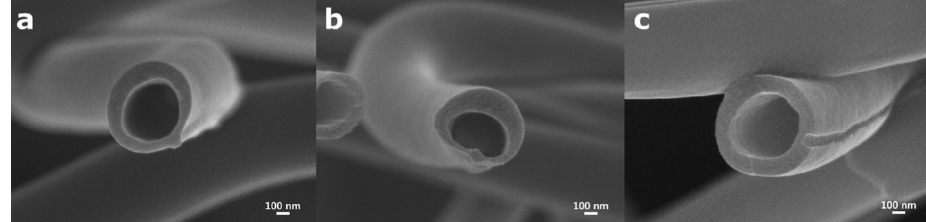
Figure 11. Different morphologies of hollow carbon nanofibers fabricated via different nozzle setups, ( a ) normal nozzle (the core and shell nozzle outlets meet at the same position); ( b ) middle nozzle (the core nozzle outlet length is shorter than that of the shell nozzle); and ( c ) core-cut nozzle (the core nozzle outlet is removed). Reprinted from ref.